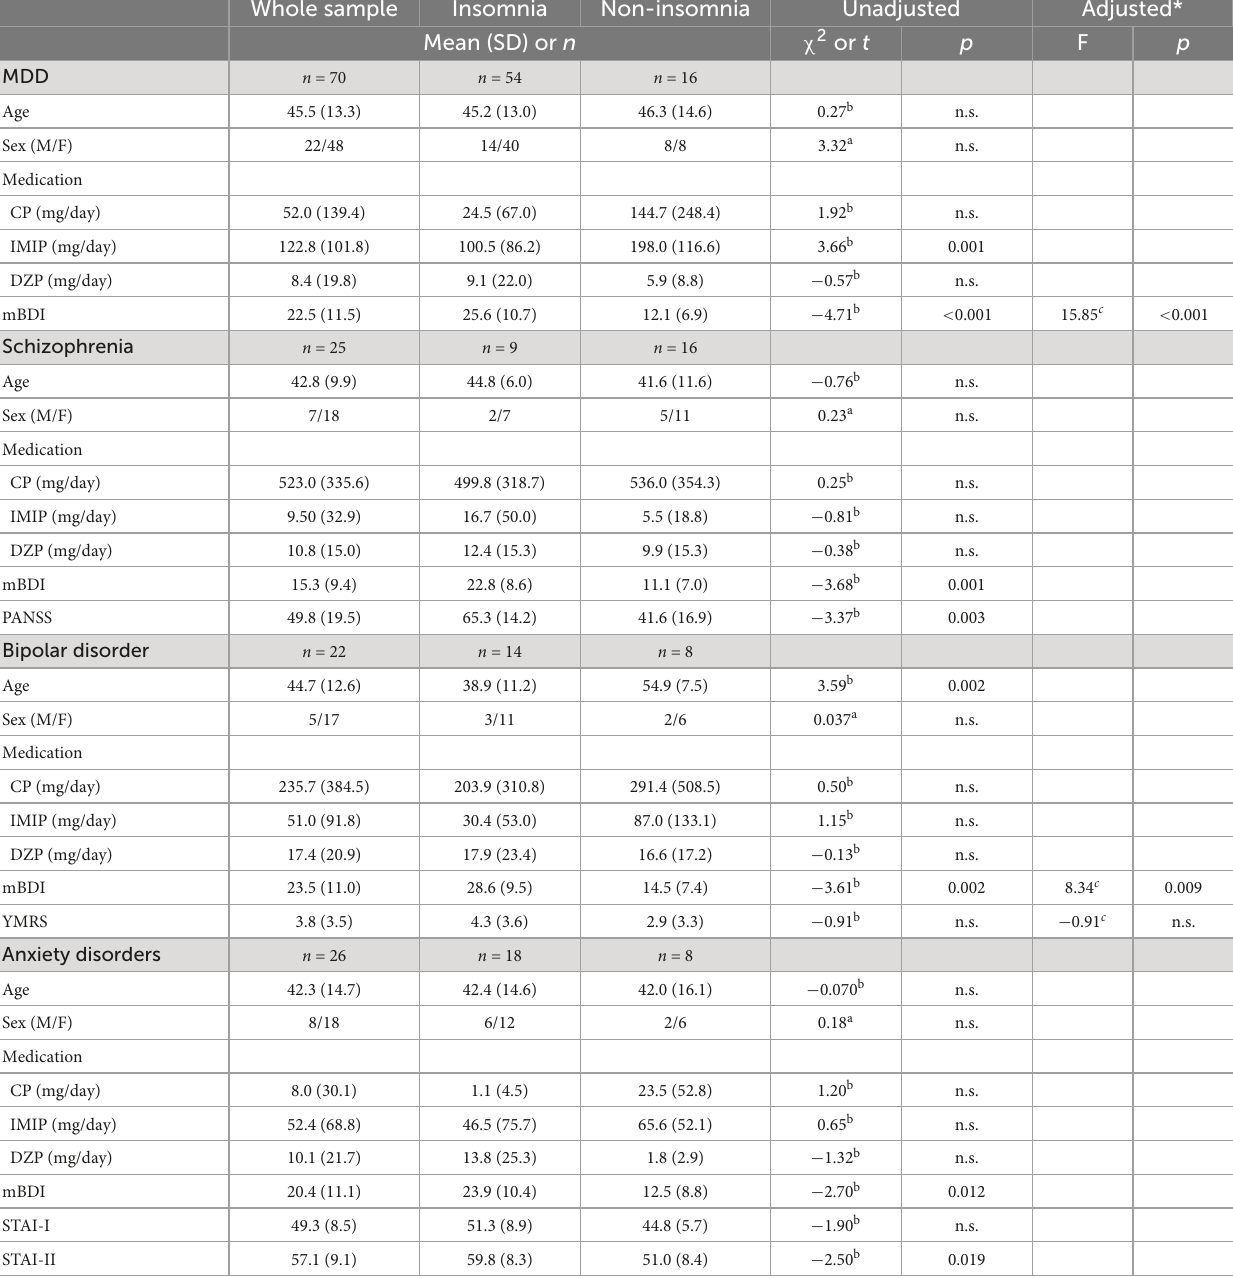
TABLE 1 Comparison of background information between the insomnia and non-insomnia groups as defined by Athens insomnia scale scores. Whole sample Insomnia Non-insomnia